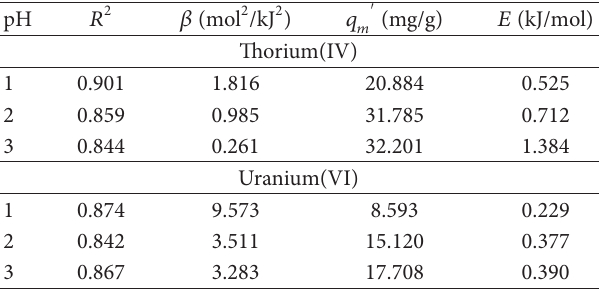
T 8: Dubinin-Radushkevich (D-R) isotherm parameters for orium(IV)andUranium(VI)atpH=1.0,2.0,and3.0at